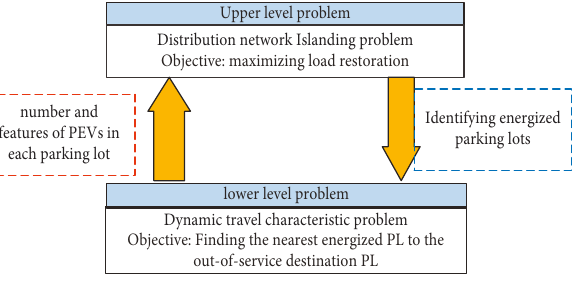
Figure 1: The proposed bilevel approach.